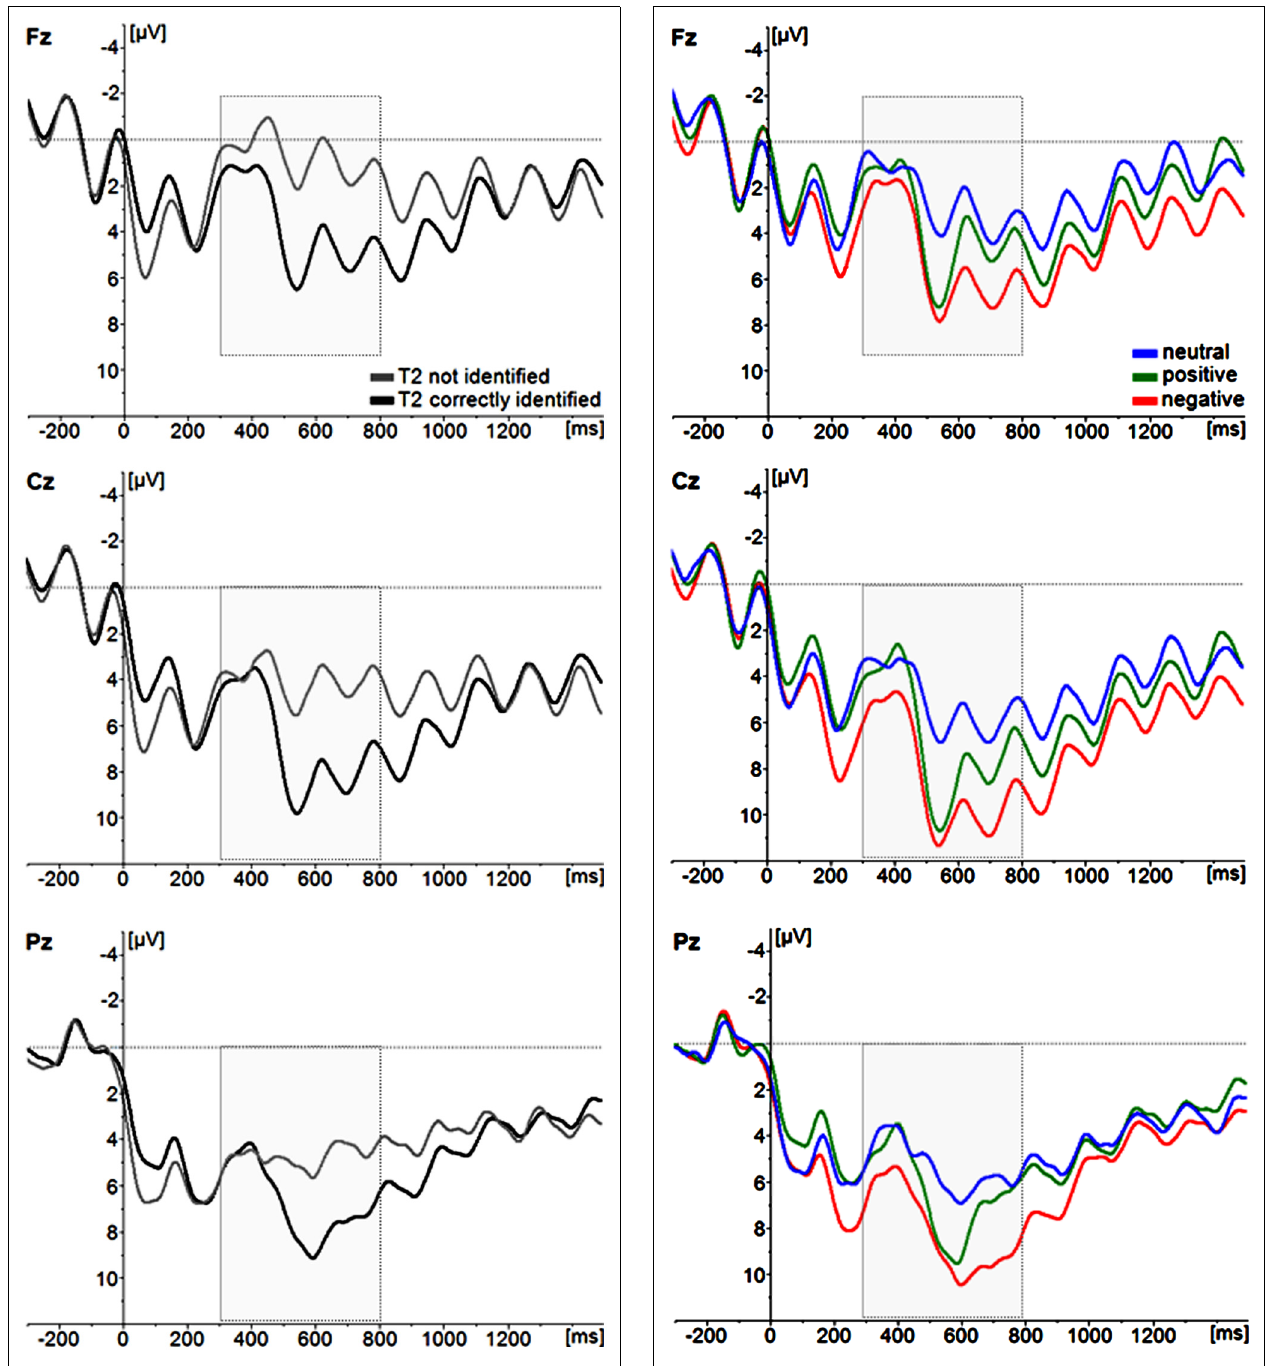
FIGURE 4 | Grand average ERP waveforms of correctly identifiedT2 image categories (neutral, positive, negative). For illustrative purposes, only the midline electrode sites Fz, Cz, and Pz are